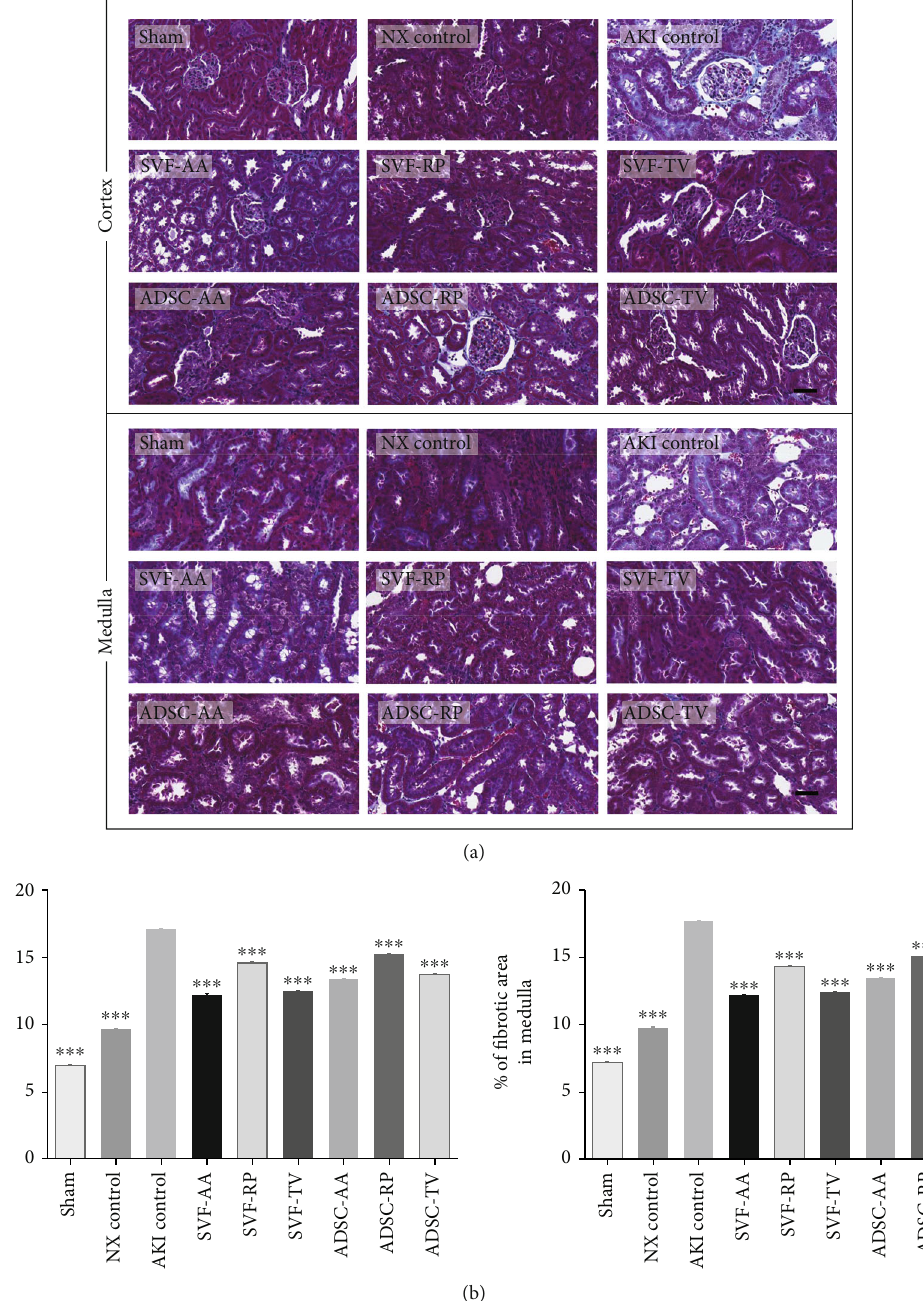
Figure 5: Masson ’ s trichrome staining of kidney tissue. (a) Representative photomicrographs of cortex and medulla. (b) Percentage of fi brotic area in random cortex area (left) and medulla area (right). Magni fi cation × 40. Scale bar 50 μ m. ∗∗∗ p < 0 : 001 compared to the AKI control group. 4 fi elds per rat; 10 rats per group, but 8 rats in the SVF-AA and ADSC-AA